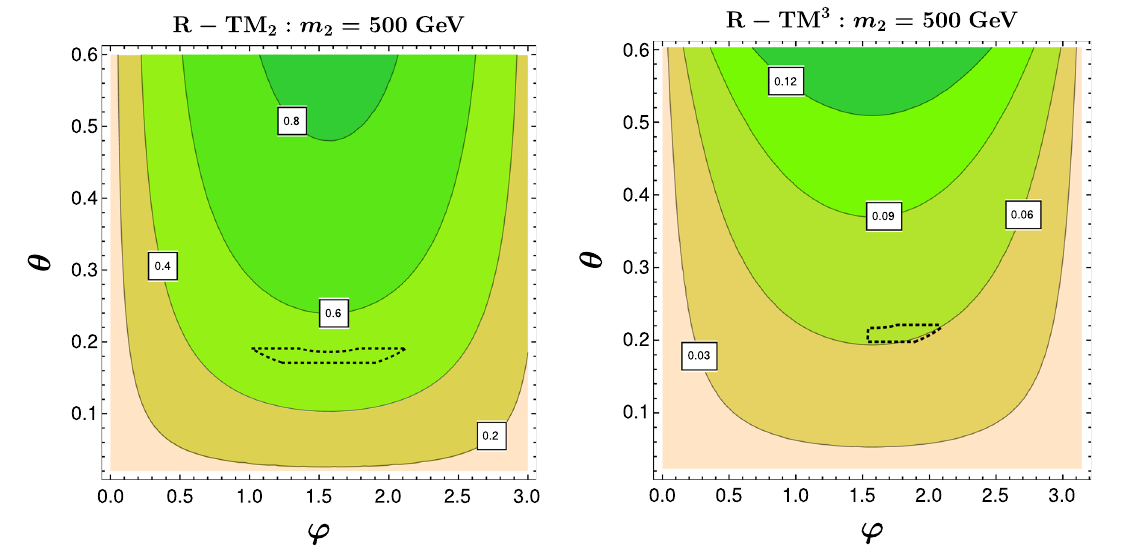
allowed range of | U | and a maximal CP measure J = J max contours denote the variations of v 2 (in unit of GeV), with each contour corresponding to the best-fit point of Y (cid:4) B given by Eq. (4.8)